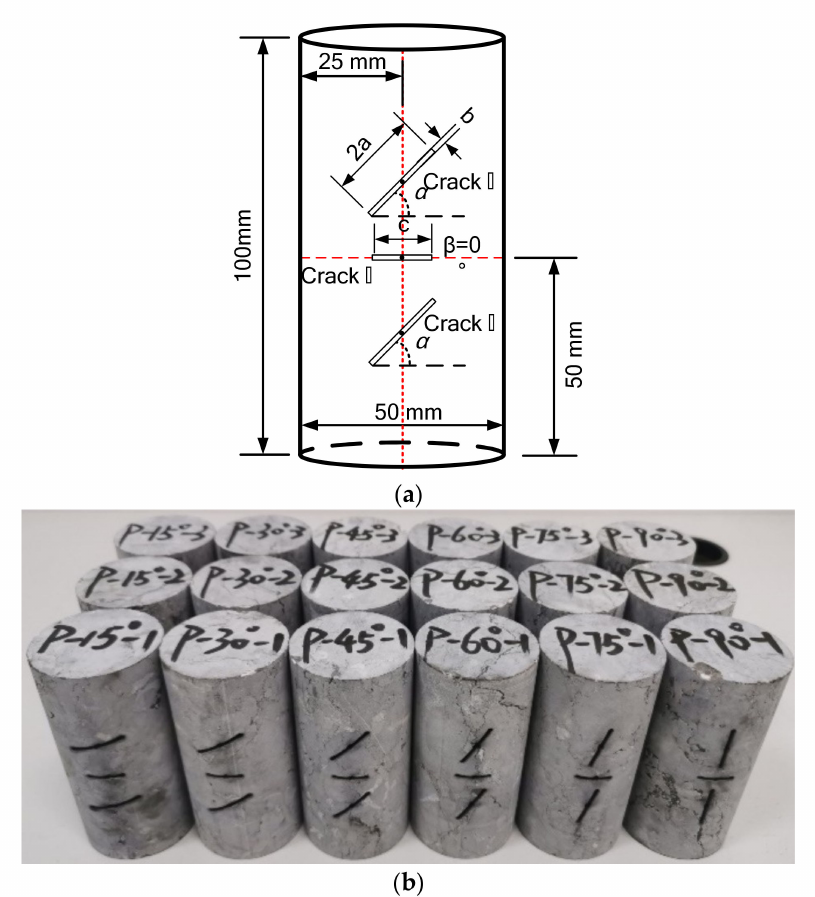
Figure 2. Images of the fractured limestone model and the specimens: ( a ) schematic diagram of the fractured limestone model; ( b ) fractured limestone